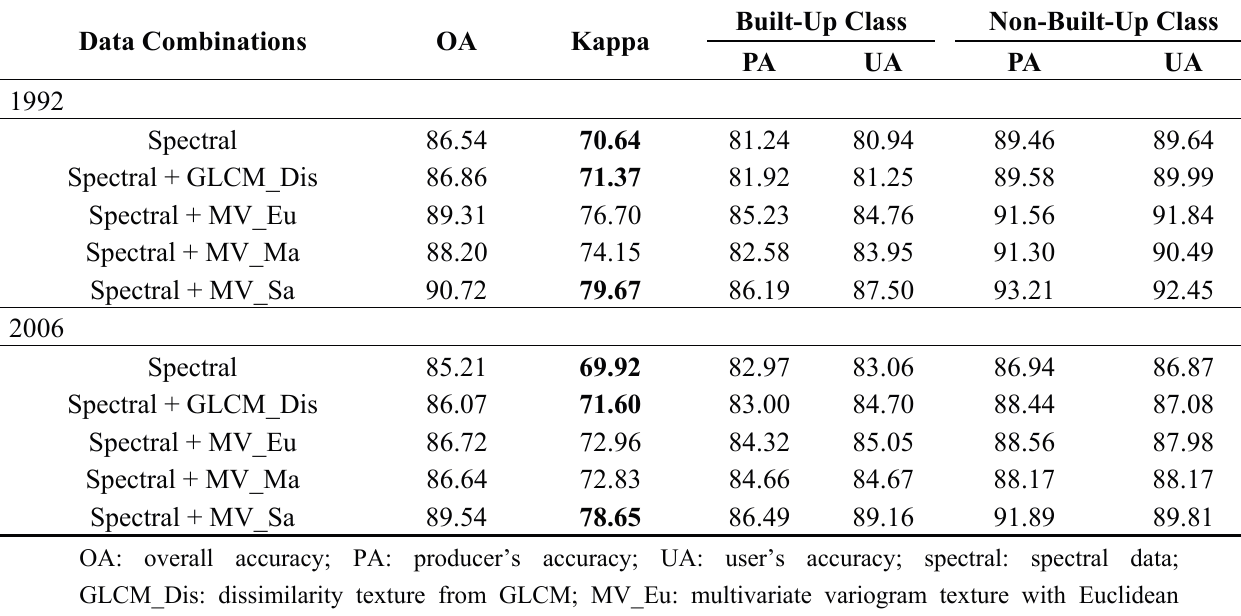
Table 6. Classification accuracies using multispectral data and texture features of the Tianjin area (all in